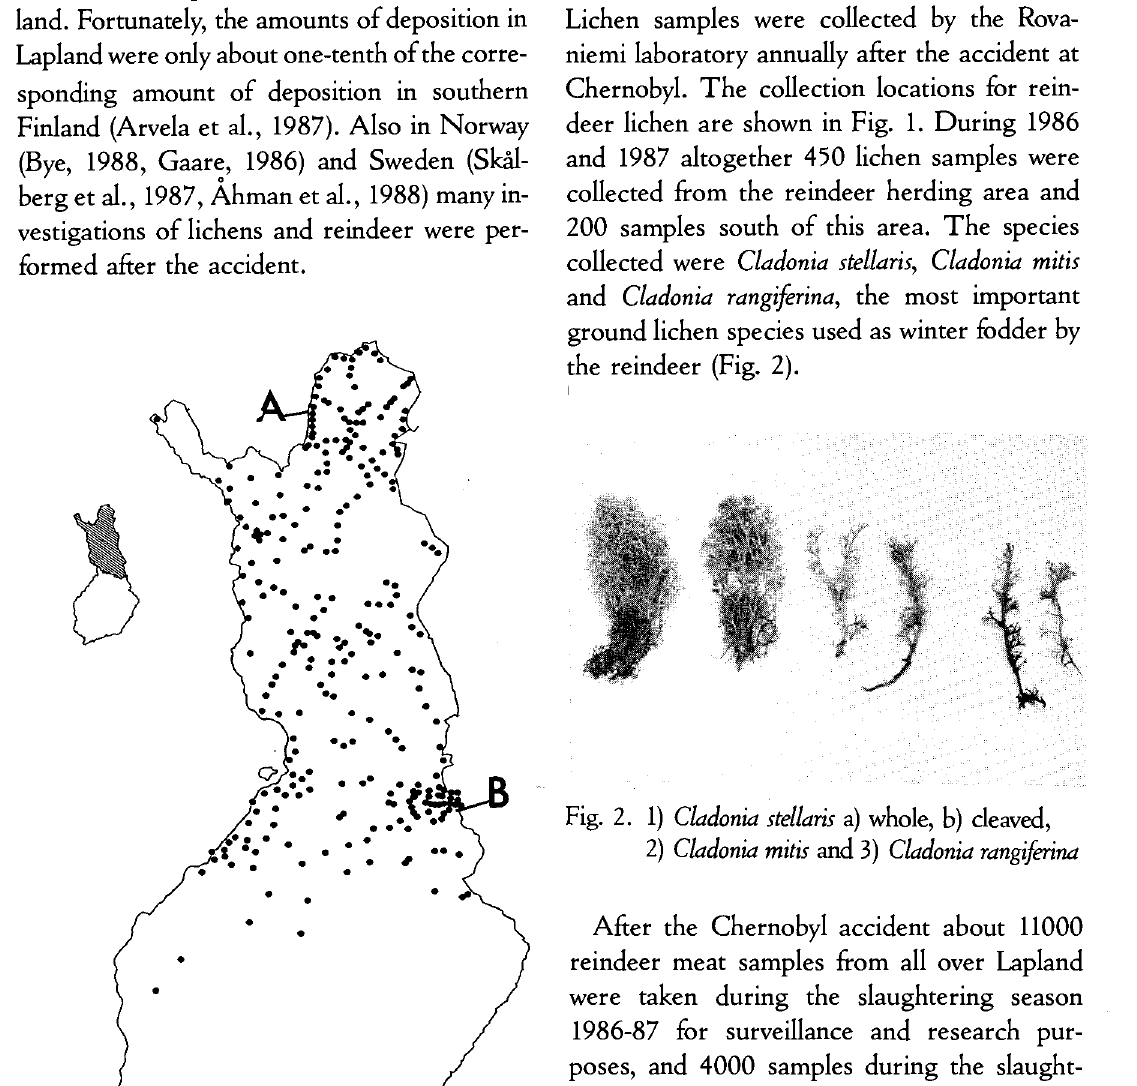
Fig. 1. Sampling locations for reindeer lichen in 1986 - 1987. All samples from the reindeer herding area (lined on the inserted map) are indicated but south of that area only the communities from which samples were ta ken. Results for the sample square collected from location A (Inari) are given in Table 1 and for those from location B (Kuhmo)